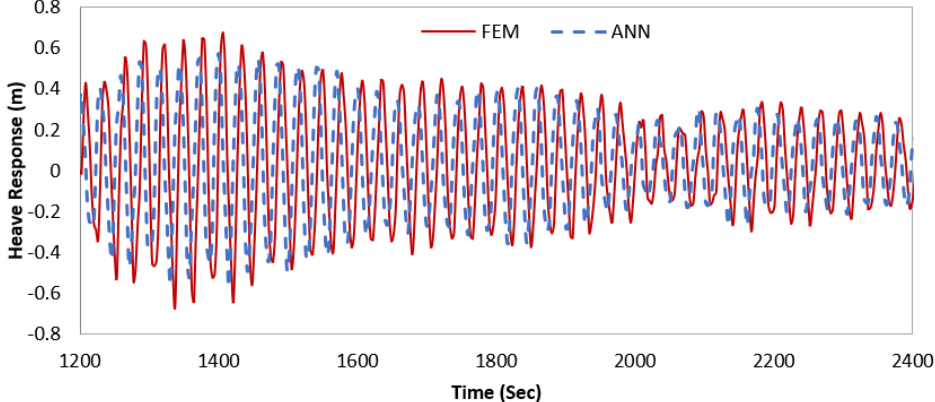
Figure 8. The heave response time history predicted by the training data of ANN and FEM results for wave height of 9.65 m and wave period of 9.94 s.